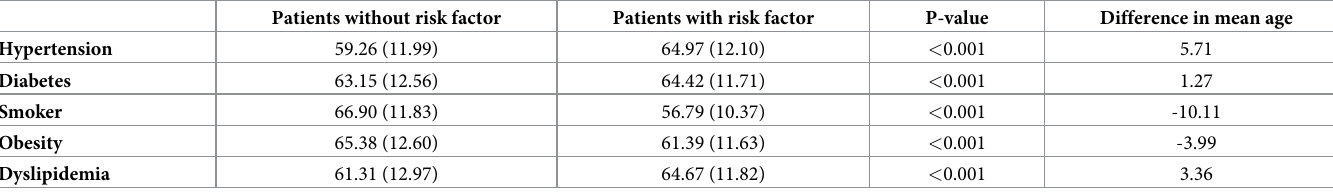
Table 3. Average age at the time of presentation among patients with and without individual risk factors. Patients without risk